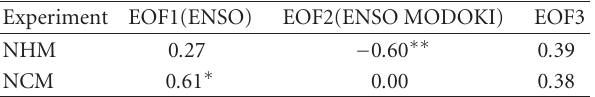
Table 3: Correlation coe ffi cients between predicted central pres- sures and normalized EOF amplitudes (calculated by Wada and Chan